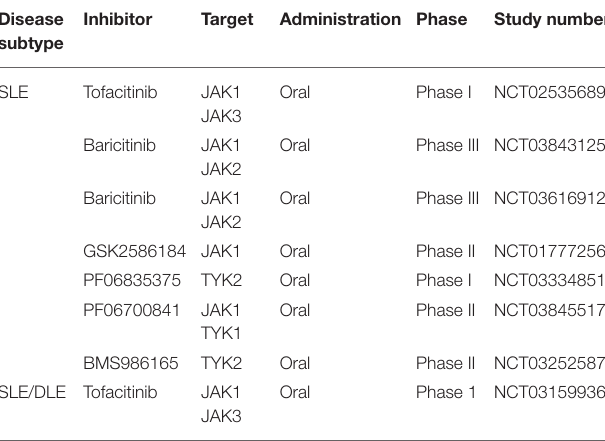
TABLE 8 | Clinical trials of JAKi in systemic and/or discoid lupus erythematosus according to clinicaltrials.gov. Disease subtype